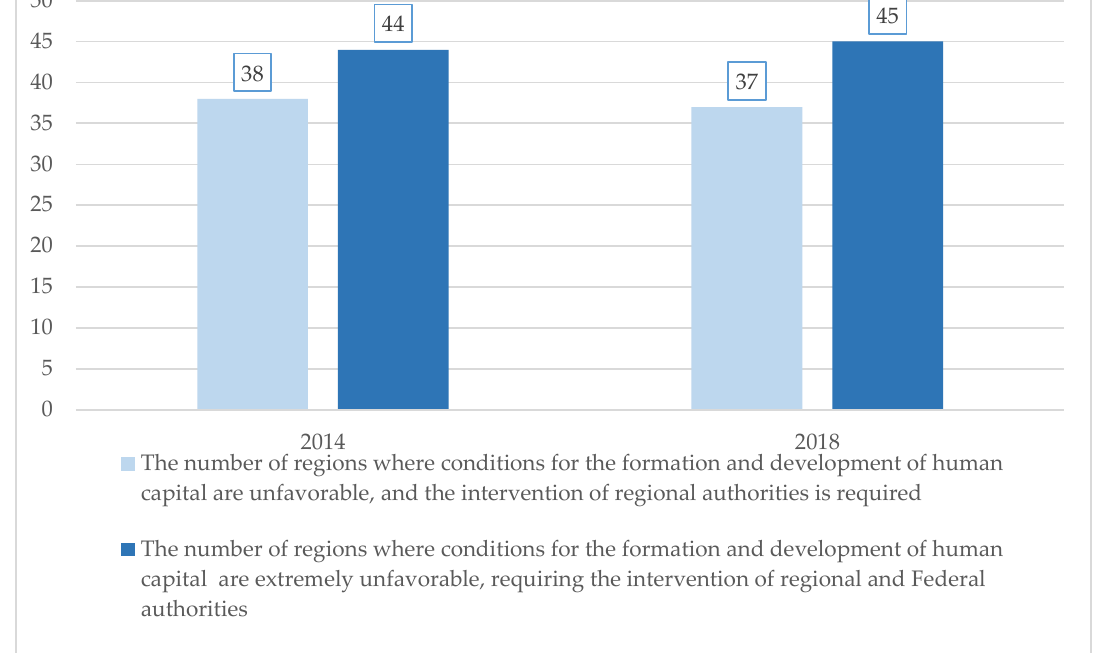
Figure 3. Distribution of the regions of the Russian Federation according to the conditions for the formation and development of human capital in 2018.